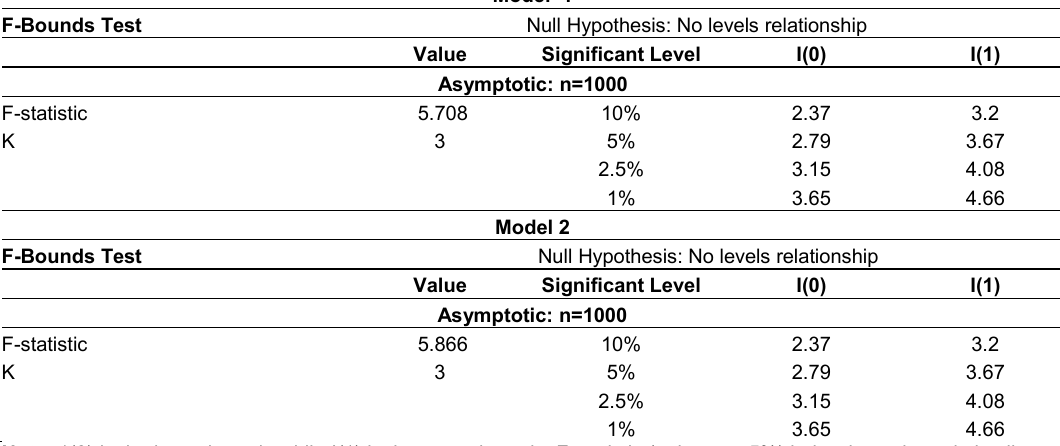
Table 5: Bounds Testing results.